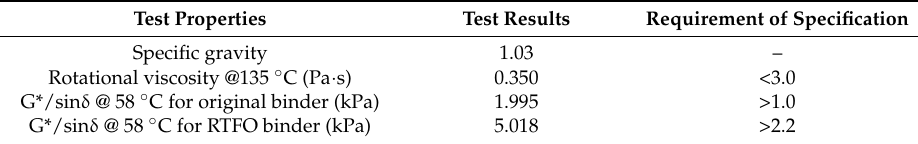
Table 1. The properties of performance grade asphalt PG 58-28.